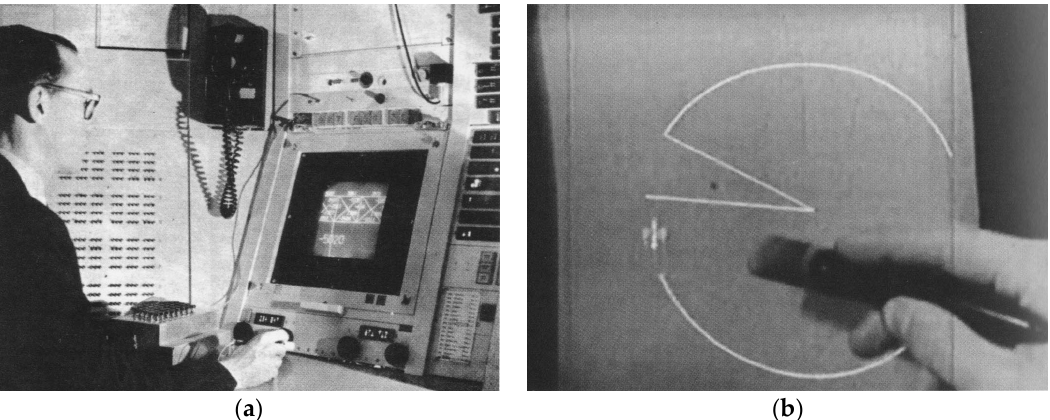
Figure 4. Sutherland’s Sketchpad : ( a ) Ivan Sutherland working with Sketchpad; ( b ) A screenshot of Sketchpad drawing of a